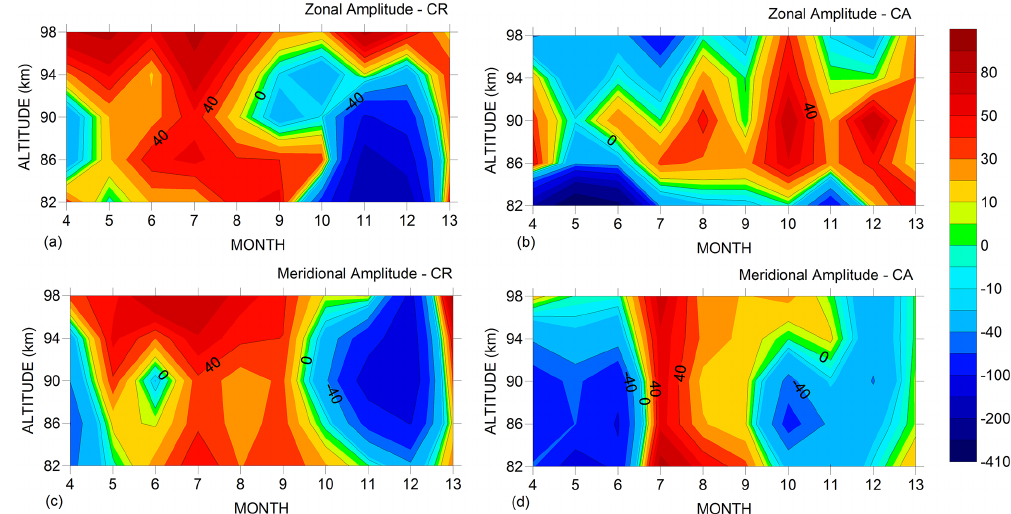
Figure 4. Difference in percentage ((model – radar) × 100/model) between GSWM-09 and radar diurnal amplitude for zonal (a, b) and meridional (c, d) components at CR and CA from April 2005 and January